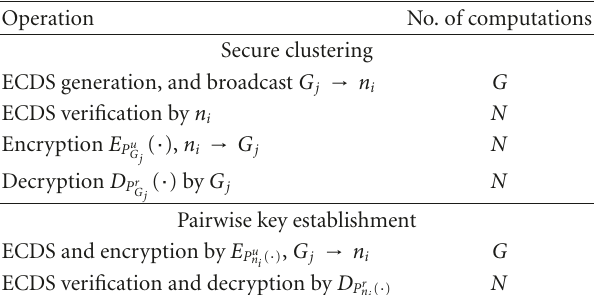
Figure 5: Number of neighbor nodes involved in the routing algorithm toward the gateway with N = 1000; G = 10; r = 100m. Table 3: Number of encryption/decryption during secure cluster- ing and pairwise key